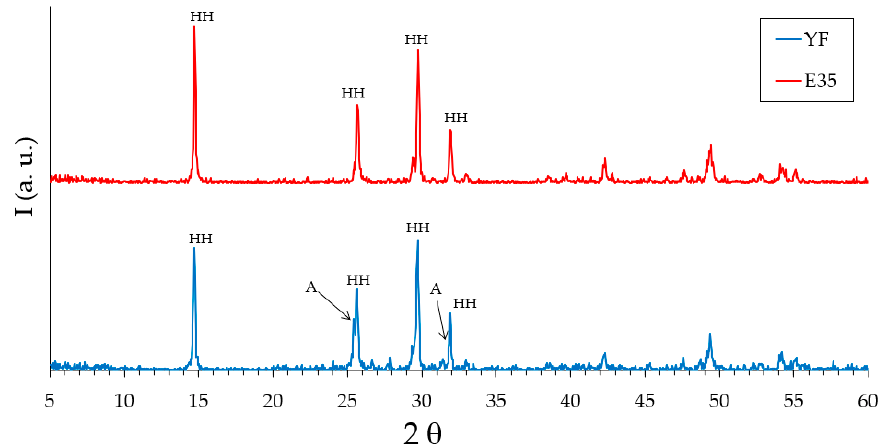
ff raction (XRD) of the raw materials. HH: hemihydrate. A: Figure 1. Analysis by X-ray diffraction (XRD) of the raw materials. HH: hemihydrate. A: anhydrite. Figure 1. Analysis by X-ray di